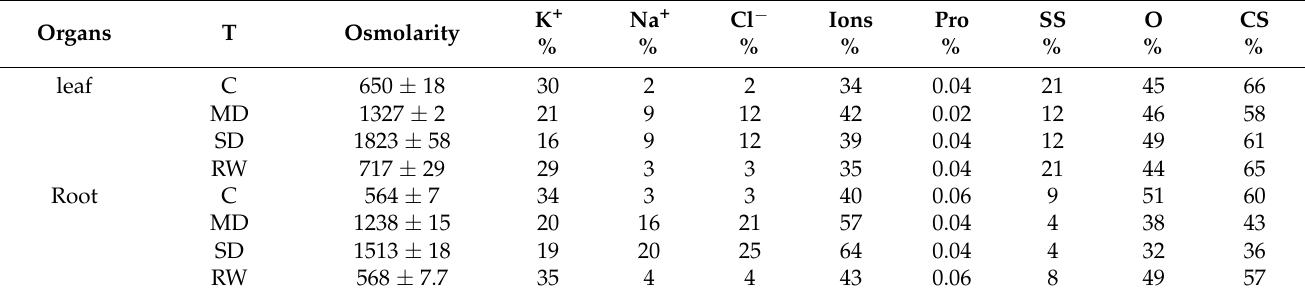
Figure 9. The osmolarity of sap in the leaves and roots of C. duriuscula under drought stress. C- control, MD-mild stress, SD-severe stress, RW-re-watering. Data are means ± SE ( n = 3–6). Data labeled with different lower-case letters are significantly different at p < 0.05. ( A ) The osmolarity of leaves and roots in control was 650 ± 18 mOsmol kg − 1 under drought stress. ( B ) The osmolarity of leaves and roots in control was 564 ± 6.3 mOsmol kg − 1 under drought stress. Table 1. The relative contribution of compatible solutes and inorganic osmolytes towards osmotic adjustment in C. duriuscula leaves and roots.